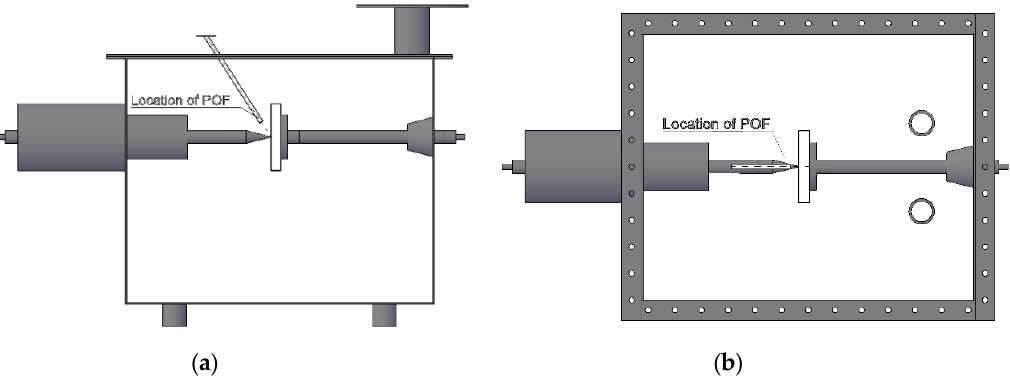
Figure 3. Surface discharge system: schematic diagram side view ( a ) and view from above ( b ).